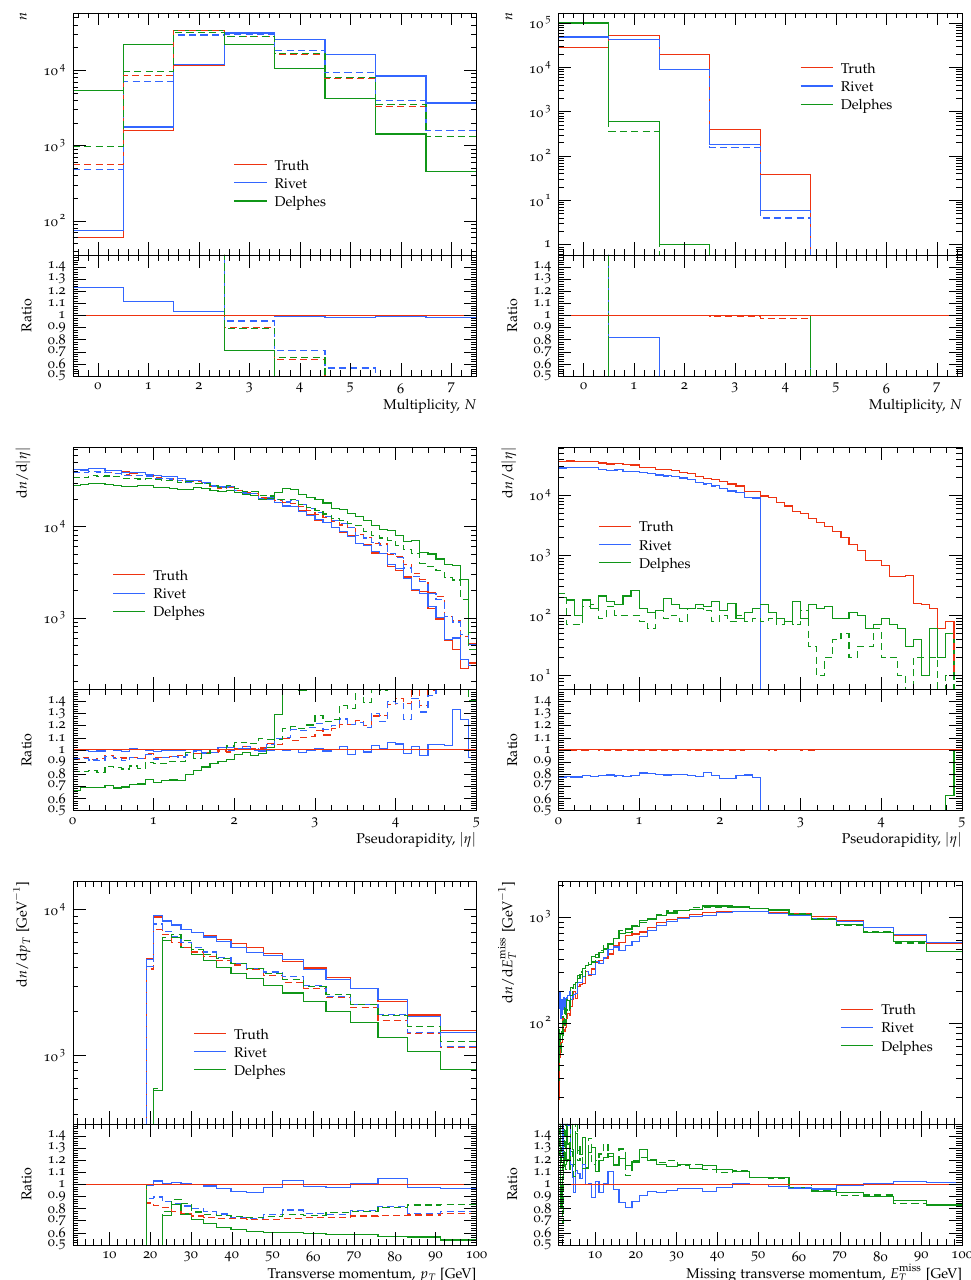
Figure 3: Jet and MET performance from Pythia8 LHC t ¯ t production at truth level, and after processing through the standard ATLAS detector emulation routines in R IVET and D ELPHES . Inclusive jet observables are shown in the left column, and b -jets in the right with the exception of the bottom row which shows the MET distribution on the RHS. For the jet objects, the observables shown are multiplicity, p | η | distribution from top to